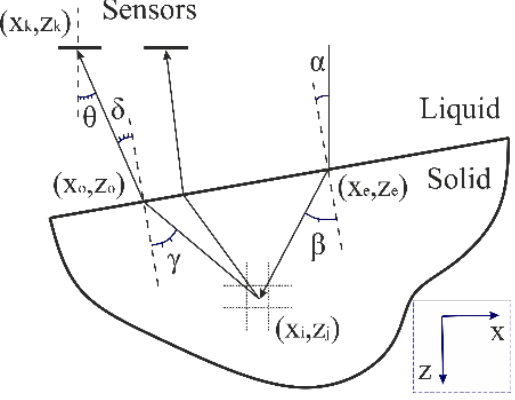
Figure 8. Propagation of waves through liquid–solid interface. Forward path on the right, backward path on the left.